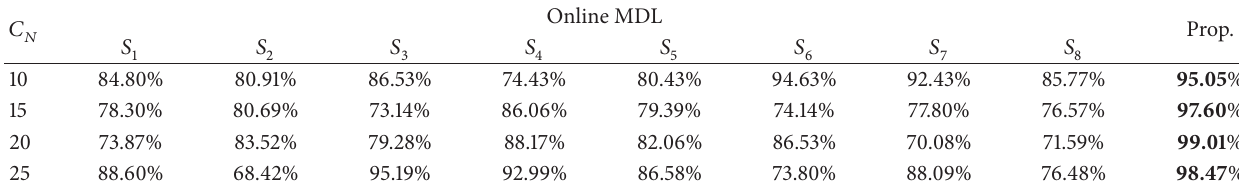
Table 2: Classification accuracy of 8 sensors.